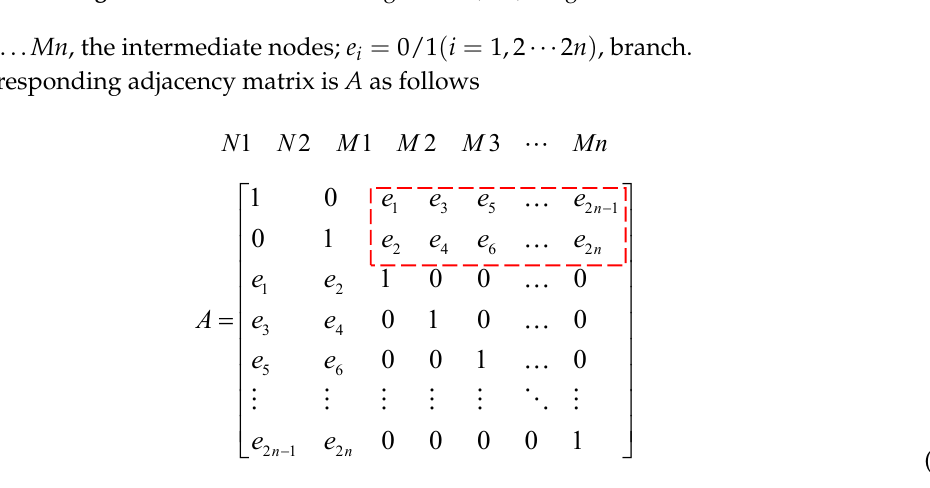
Figure 7. AARS connection diagram. N 1, N 2, the generalized nodes.